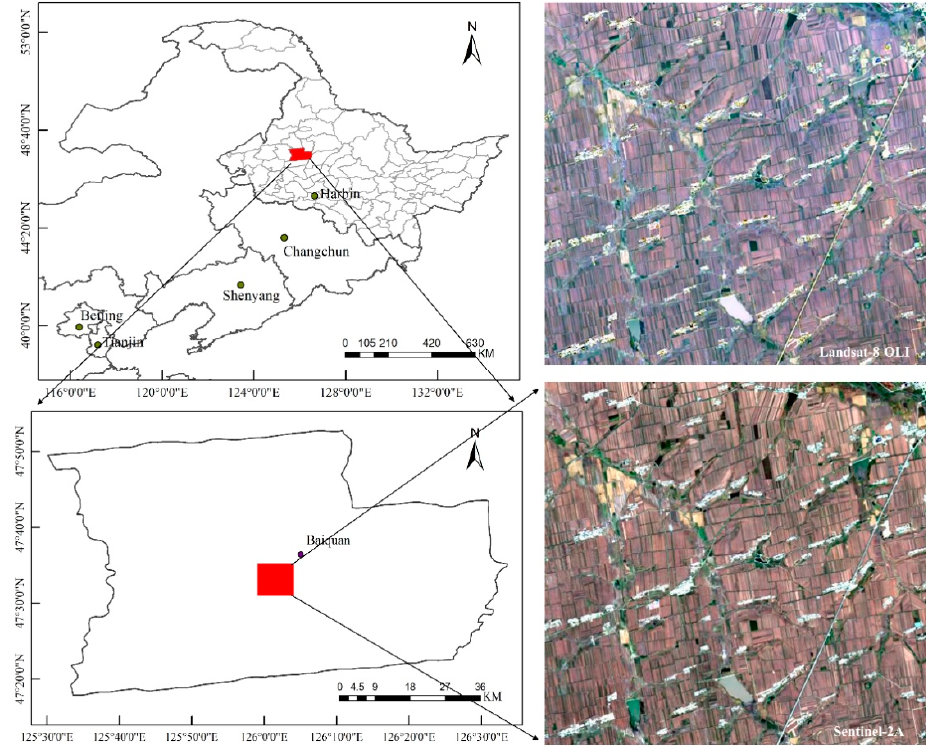
Figure 1. Scope and true color images of the study area.